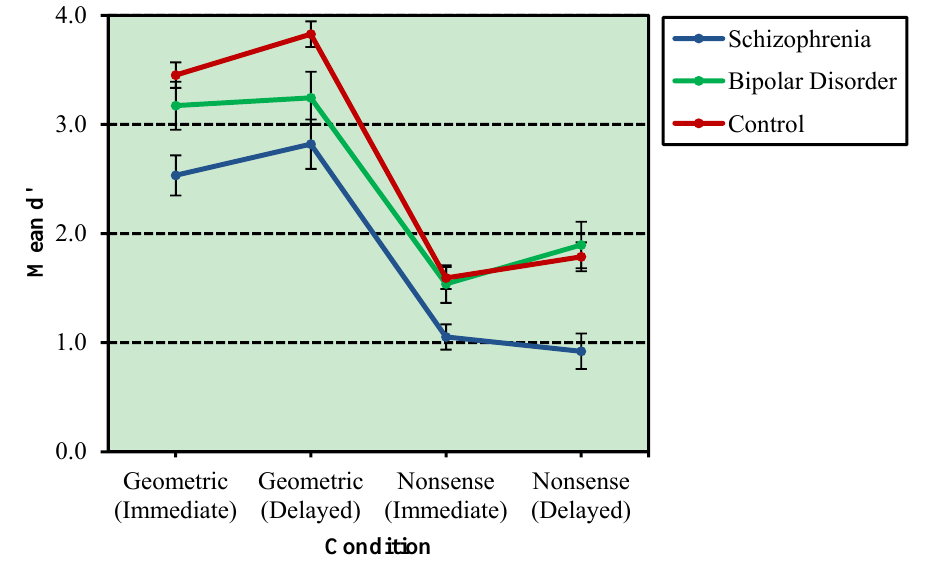
Figure 2. Comparison of mean d' for schizophrenia probands, bipolar probands and nonpsychiatric controls by stimulus and time delay. Probands with schizophrenia had lower d´ scores compared to both nonpsychiatric controls and probands with bipolar disorder in all conditions, except delayed recognition for geometric designs, where bipolar probands did not differ significantly from either the schizophrenia probands or the controls.